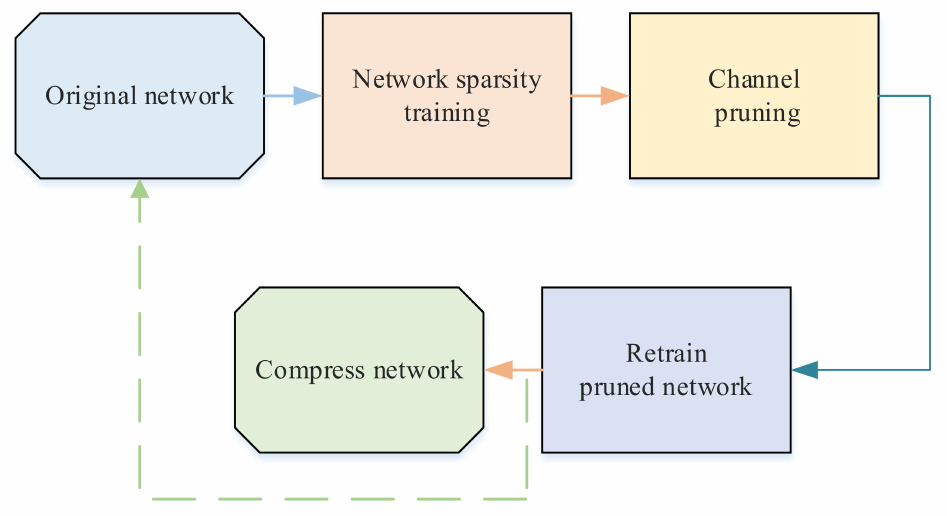
Figure 6. The pruning